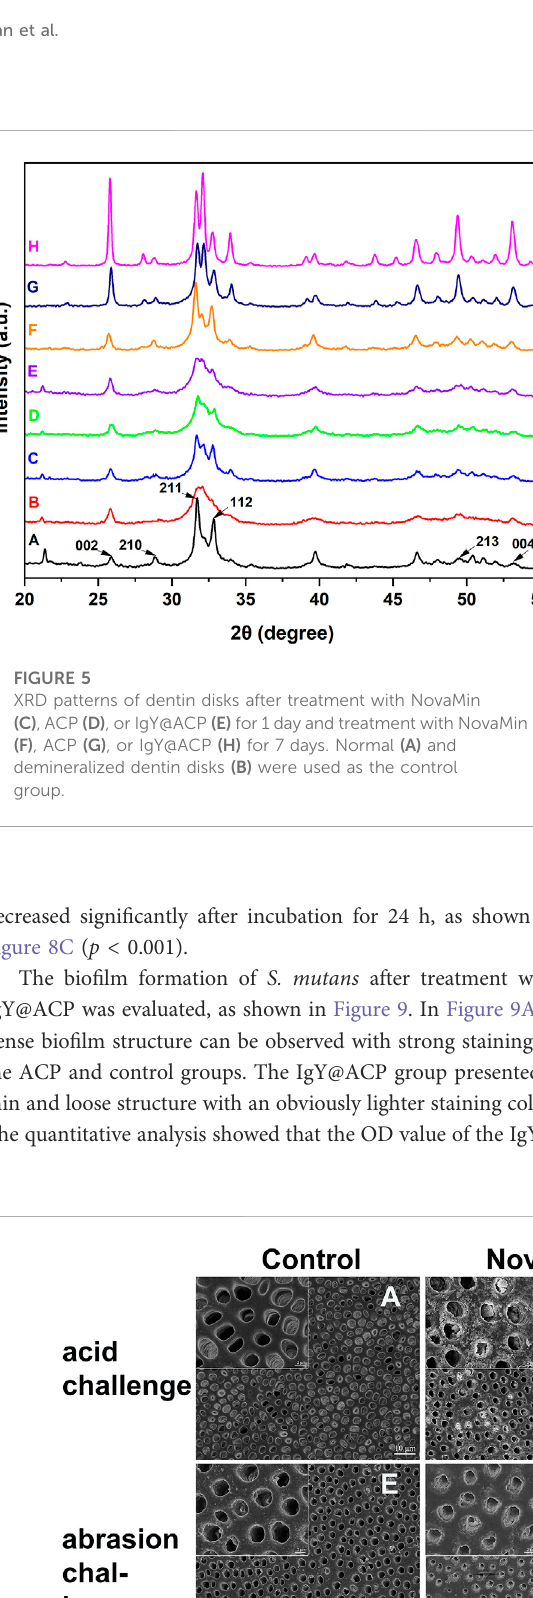
Frontiers in Bioengineering and